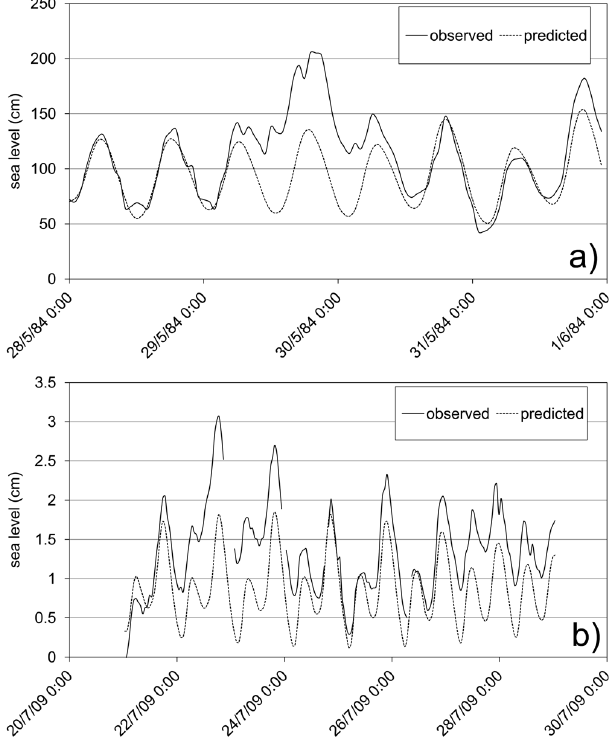
Fig. 6. (a) Time series of the MSL at Buenos Aires and Mar del Plata updated to 2010. (b) Time series of the RSLR at Buenos Aires, eustasy (i.e., the RSLR corrected of the VLM recorded by the GPS in Buenos Aires) and reconstructed RSLR (i.e., the eustacy plus the VLM) in the Samboromb´on Bay.